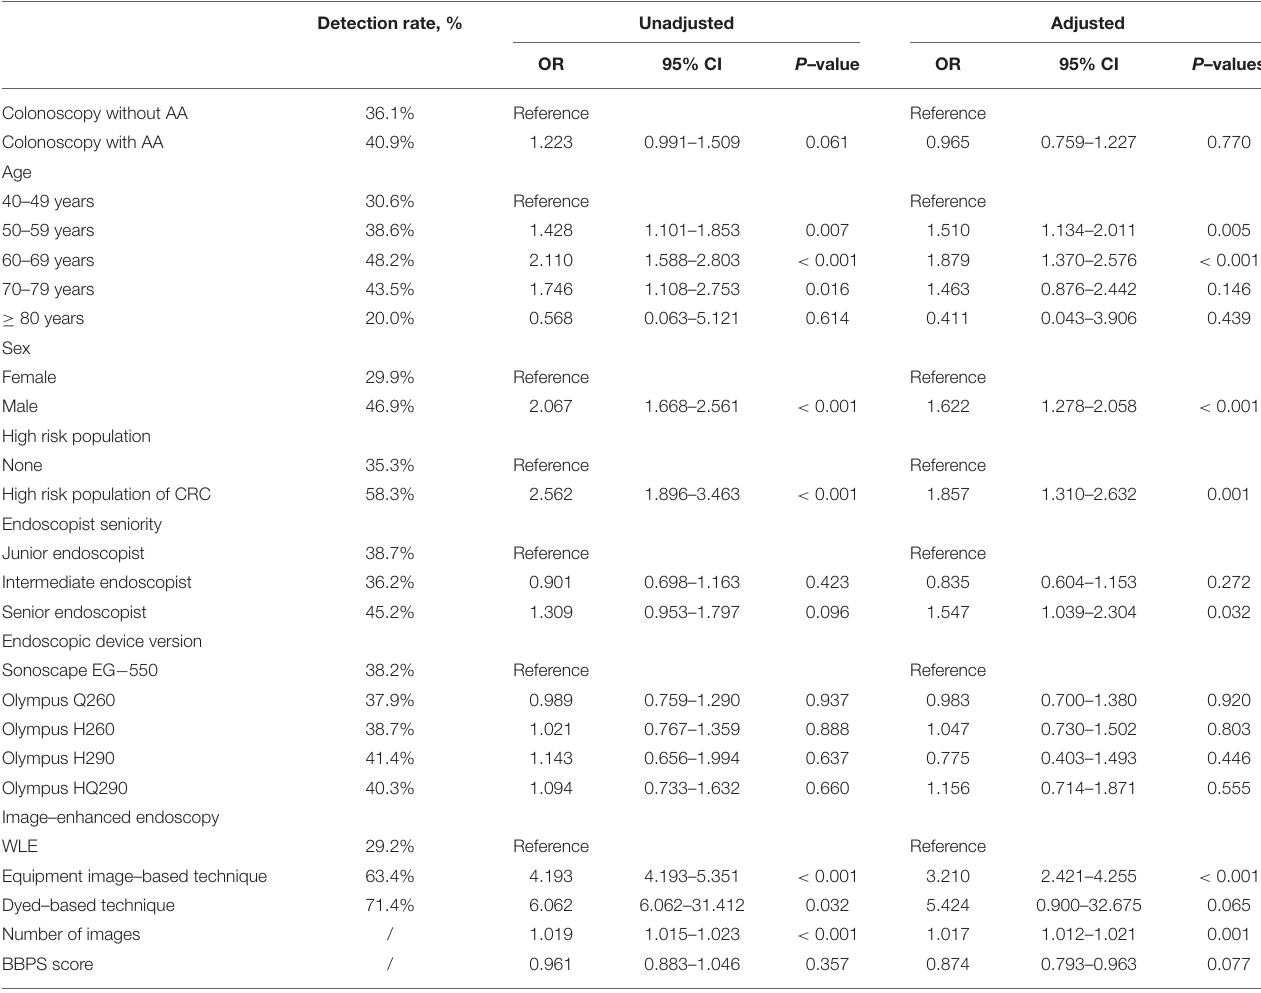
TABLE 4 | Logistic regression analysis for PDR in the propensity–matched cohort. Detection rate,